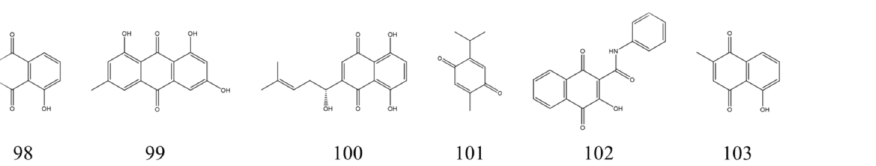
Figure 8. Structural formulae of quinones with IBD therapeutic effects. Table 5. In vivo therapeutic effects of quinones on experimental IBD.